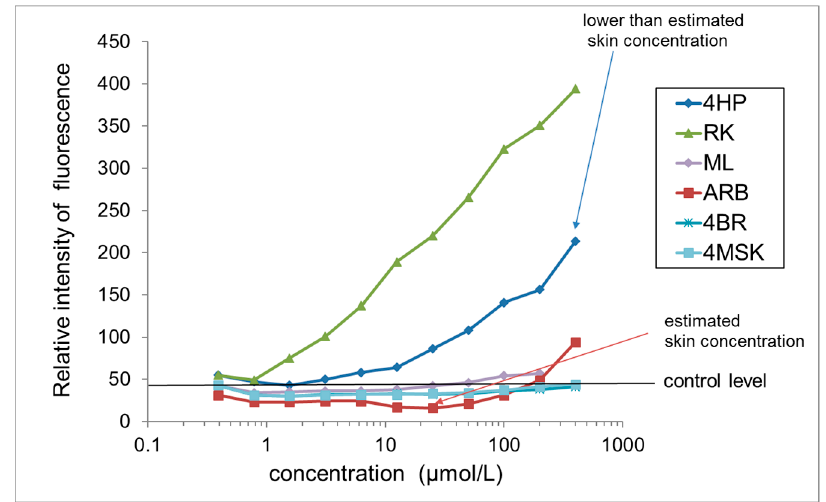
Figure 6. Comparison of H 2 O 2 generation by test ingredients in the presence of tyrosinase. Results are presented as the mean of three experiments. 4HP, rhododendrol; RK, raspberry ketone; ML, magnolignan; ARB, arbutin; 4BR, 4-n-butylresorcinol; 4MSK, 4-methoxysalicylic acid potassium salt.